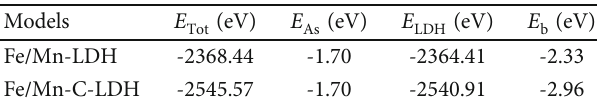
Table 8: Binding energy of the interaction between LDH and